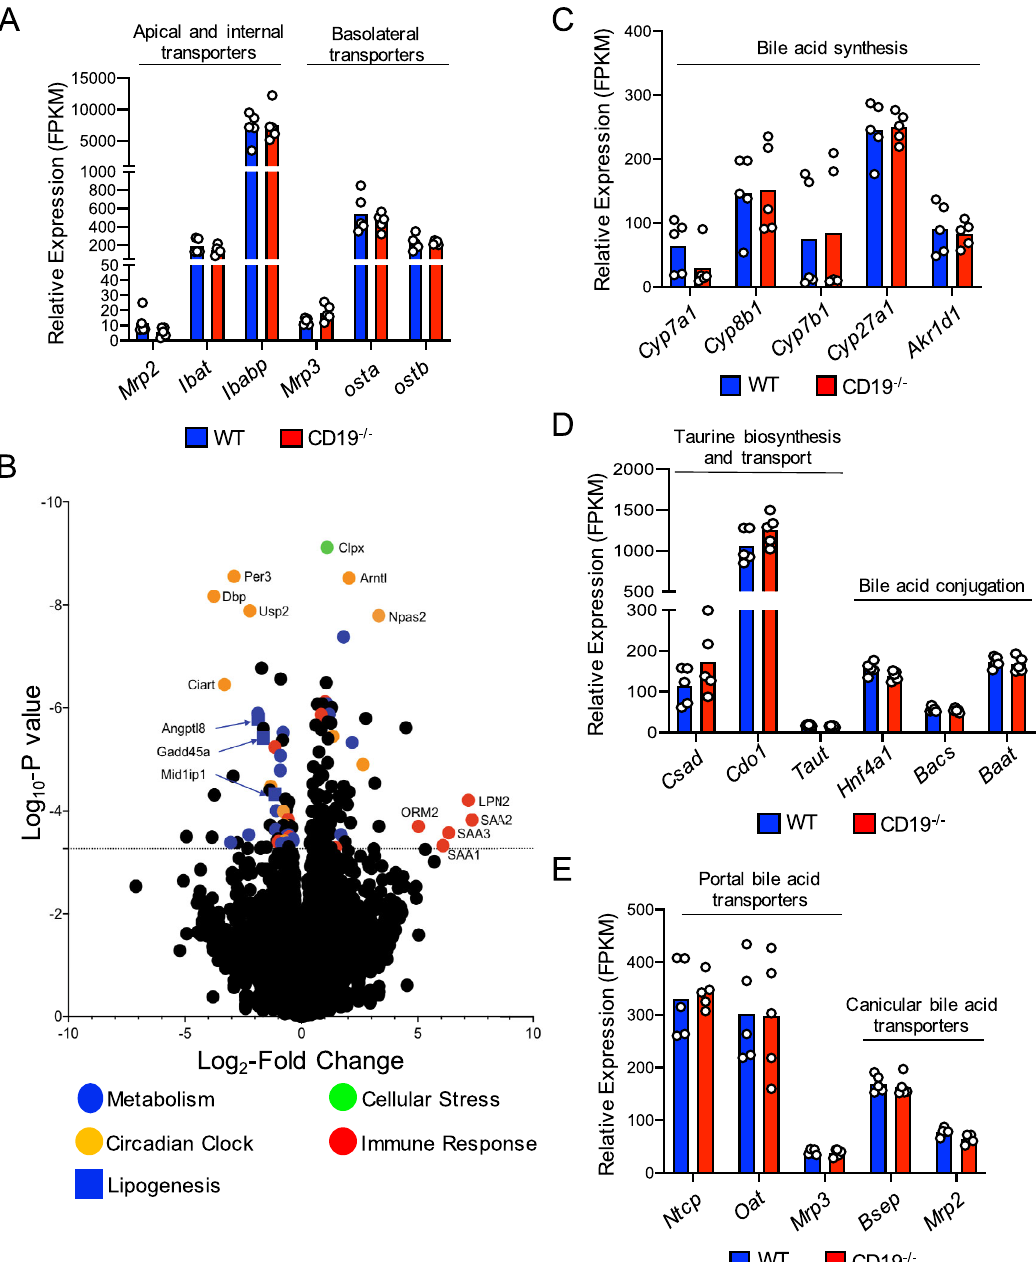
Fig. 2 BA abnormalities are not due to host defects in Bile acid synthesis, conjugation, or reabsorption in CD19 − / − mice. A Gene expression of bile acid transporters in the distal ileum of mice. B Volcano plot of major differentially regulated genes in the liver of CD19 − / − mice compared to WT controls. The FDR-adjusted signi fi cance cutoff (FDR < 0.05) of quasi-likelihood hypothesis testing is illustrated by line along Y -axis. C Gene expression of liver enzymes involved in bile acid synthesis. D Gene expression of liver enzymes associated with taurine biosynthesis and bile acid conjugation. E Gene expression of liver bile acid transporters. A – E Data is representative of one ileal RNAseq and one liver RNAseq experiment each containing fi ve biological replicates for each genotype. Signi fi cance determined by quasi-likelihood testing with an FDR signi fi cance cutoff of <0.05. None of the genes shown are differentially regulated based on FDR-adjusted p-values. Ileal and liver RNAseq data sets are derived from the same set of 5 female WT and 5 female CD19 − / − mice. Source data are provided as a Source Data fi